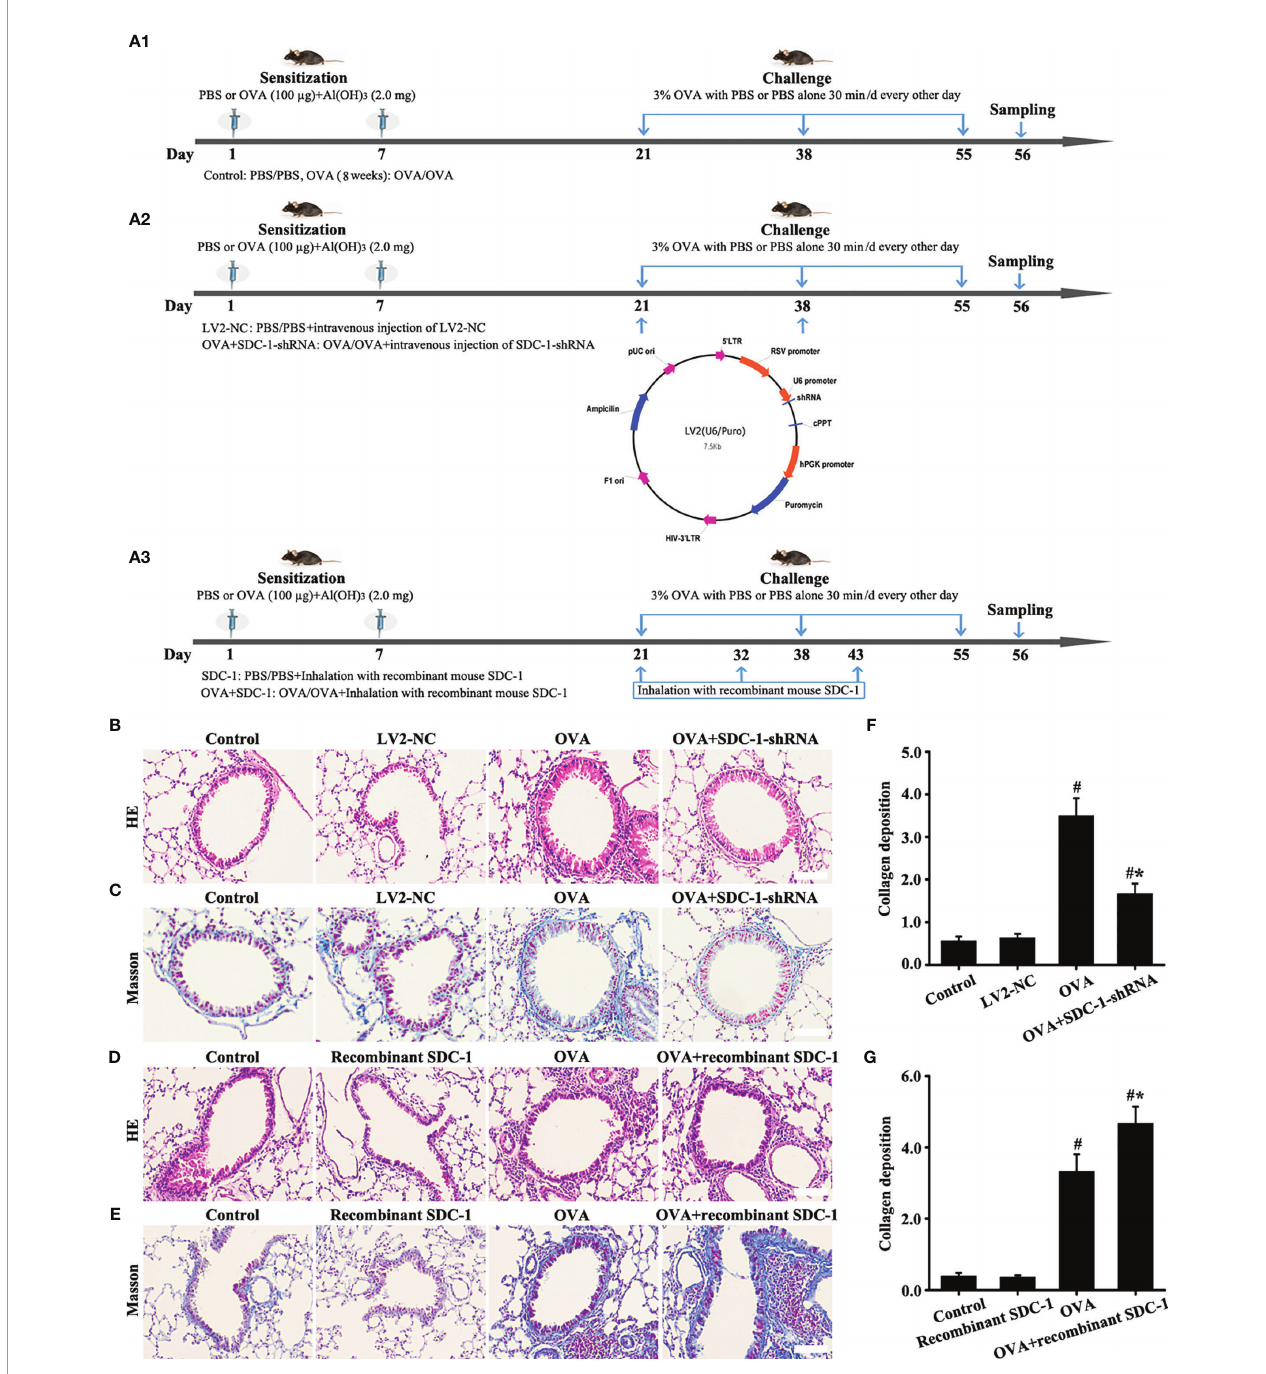
FIGURE 8 | Animal experimental intervention schedule is shown in (A) . Effects of SDC-1 deletion by SDC-1 shRNA or inhalation with the recombinant mouse SDC-1 protein on collagen deposition (C , E) and pathological changes (B , D) were observed. (F, G) Collagen intensity analysis of (C, E) , respectively. Data are shown as the means ± SD of three independent experiments. # p < 0.05 versus the control group. # *p < 0.05 versus the OVA